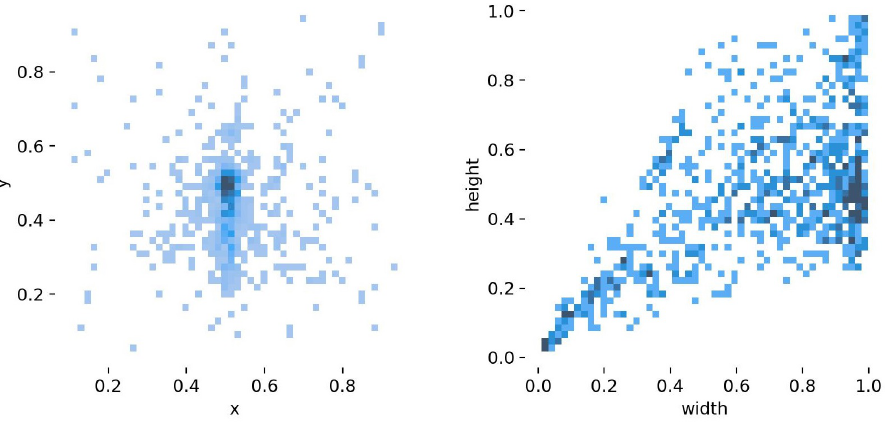
Figure 4. Categories of rotary-wing UAVs, with different propeller guards.